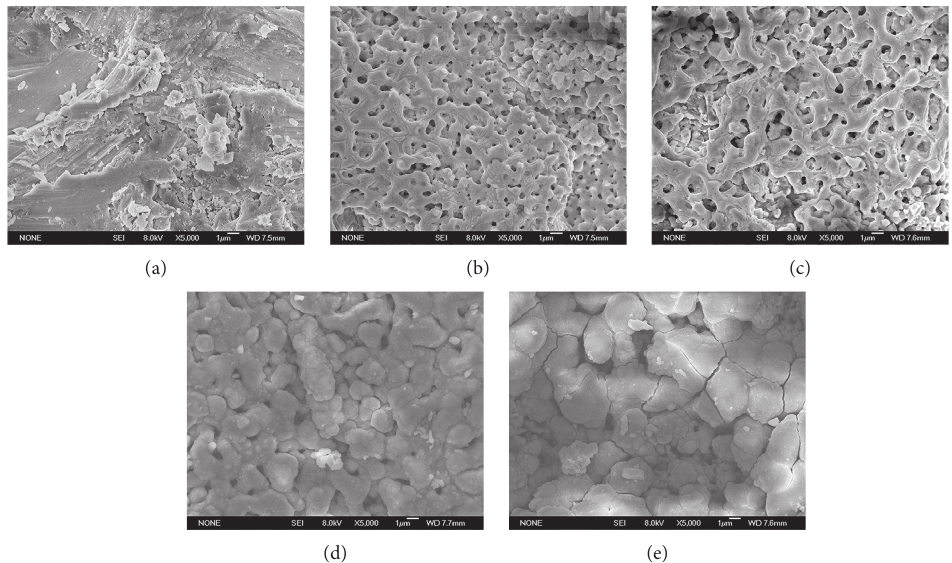
6 group, (c) 20 g/L MgSiF 6 group, (d) 30g/L MgSiF 6